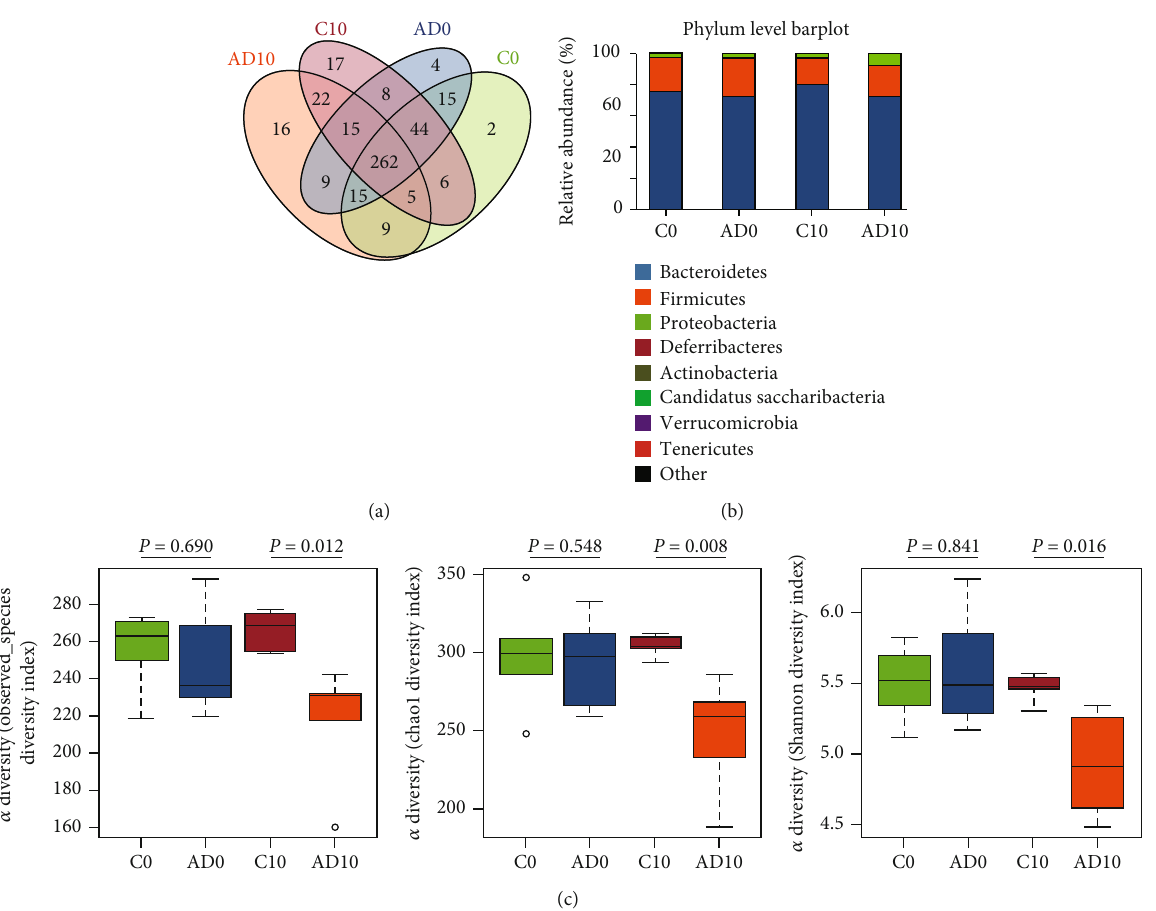
Figure 3: The gut microbiota composition at 0 and 10 weeks. (a) Venn diagram in the control and AOM/DSS group. (b) The abundance of Bacteroidetes decreased in the AOM/DSS group at 10 weeks, and the Firmicutes increased. (c) The α -diversity (observed species, chao1, and Shannon) showed no signi fi cant distinction between the two groups at 0 weeks, but it was dramatically reduced in the AOM/DSS group compared with the control group at 10 weeks. C0 and C10: control group at 0 and 10 weeks. AD0 and AD10: AOM/DSS group at 0 and 10 weeks. n = 5 in each